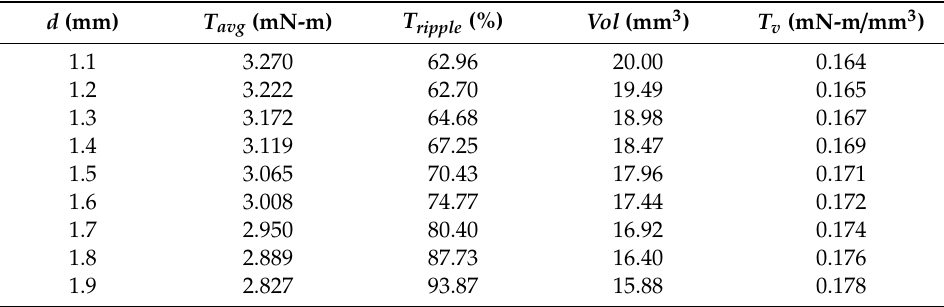
Table 3. The final design was selected with an interpole iron width of 1.6 mm. The motor had an average torque of 3.008 mN-m, a torque ripple of 74.77%, and a torque density of 0.172 mN-m/mm 3 . Table 3. Motor characteristics with interpole iron widths between 1.1 mm and 1.9 mm .